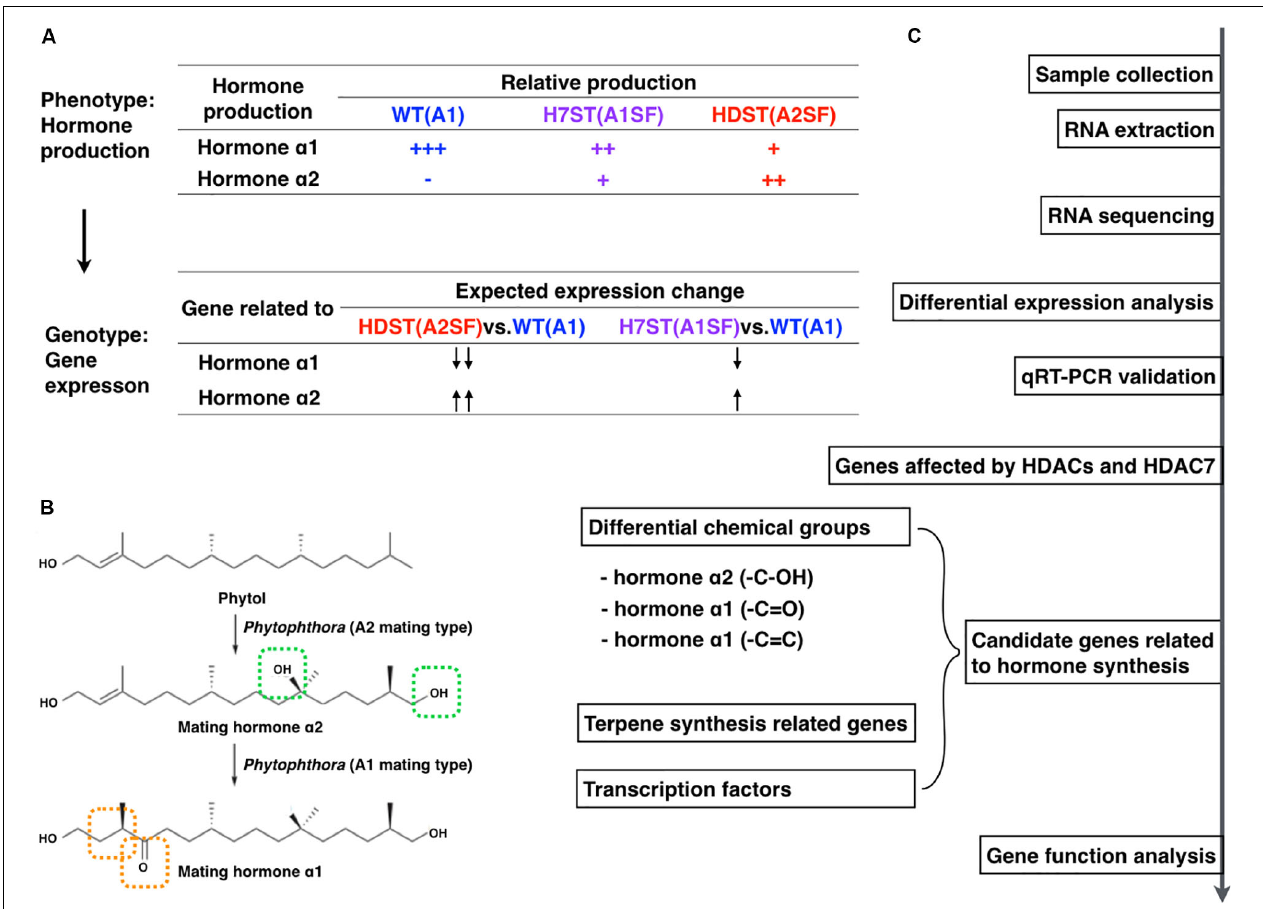
FIGURE 1 | Experimental design and workflow. (A) Expected expression-level changes to genes associated with sex hormone biosynthesis in WT, HDST, and H7ST strains according to the differences in hormone production in these strains. (B) Chemical structures of α 1 and α 2 hormones and the predicted hormone biosynthesis pathway with phytol as a precursor (modified from Ojika et al., 2011). (C) Study